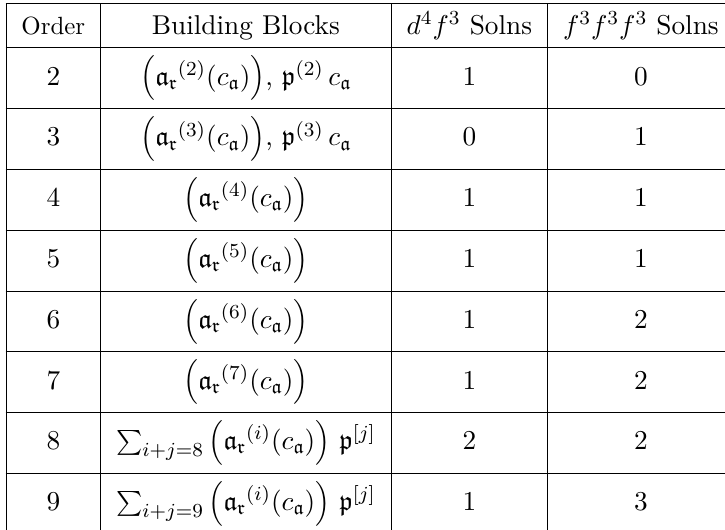
Table 5 . Necessary building blocks to construct consistently factorizing adjoint modified color numerators c HD , along with the final number of fixed factorizing solutions at each